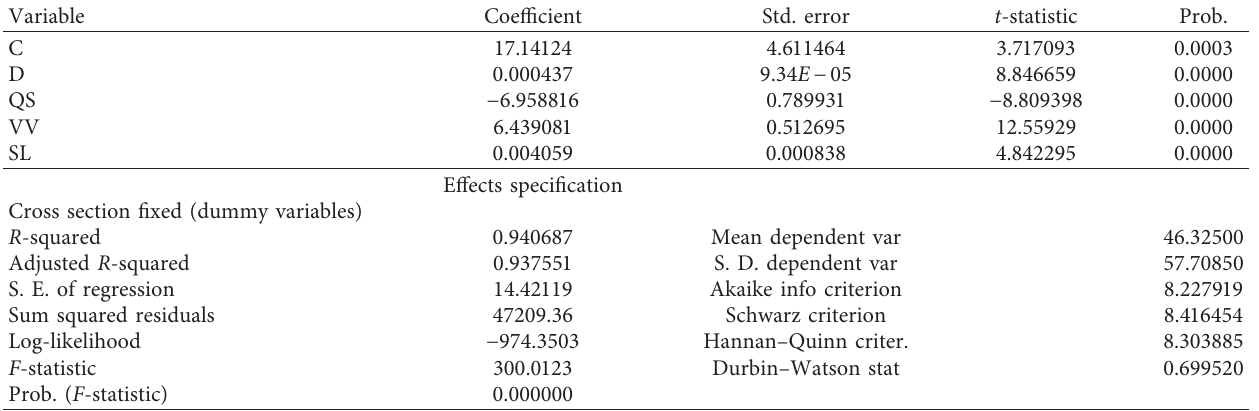
Table 3: Panel data regression